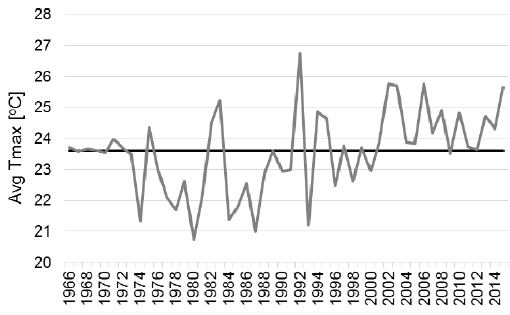
Figure 2. Average T max in the summer season in Pozna ń – Ł awica in the years 1966–2015.